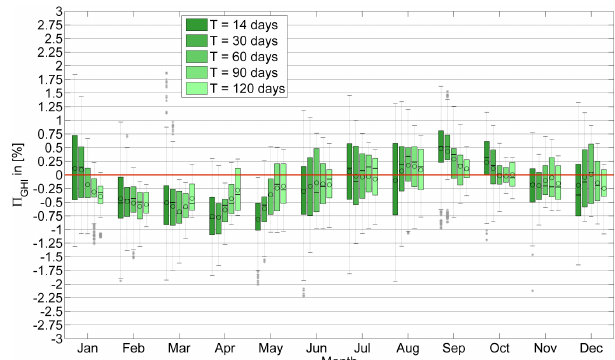
Figure 5. DLR2008: distribution of (cid:53) GHI for T = 14 days, 30 days, 60 days, 90 days and 120 days sorted by calibration starting month. (cid:53) GHI represents the deviation of calibration results from a long- term calibration for GHI.